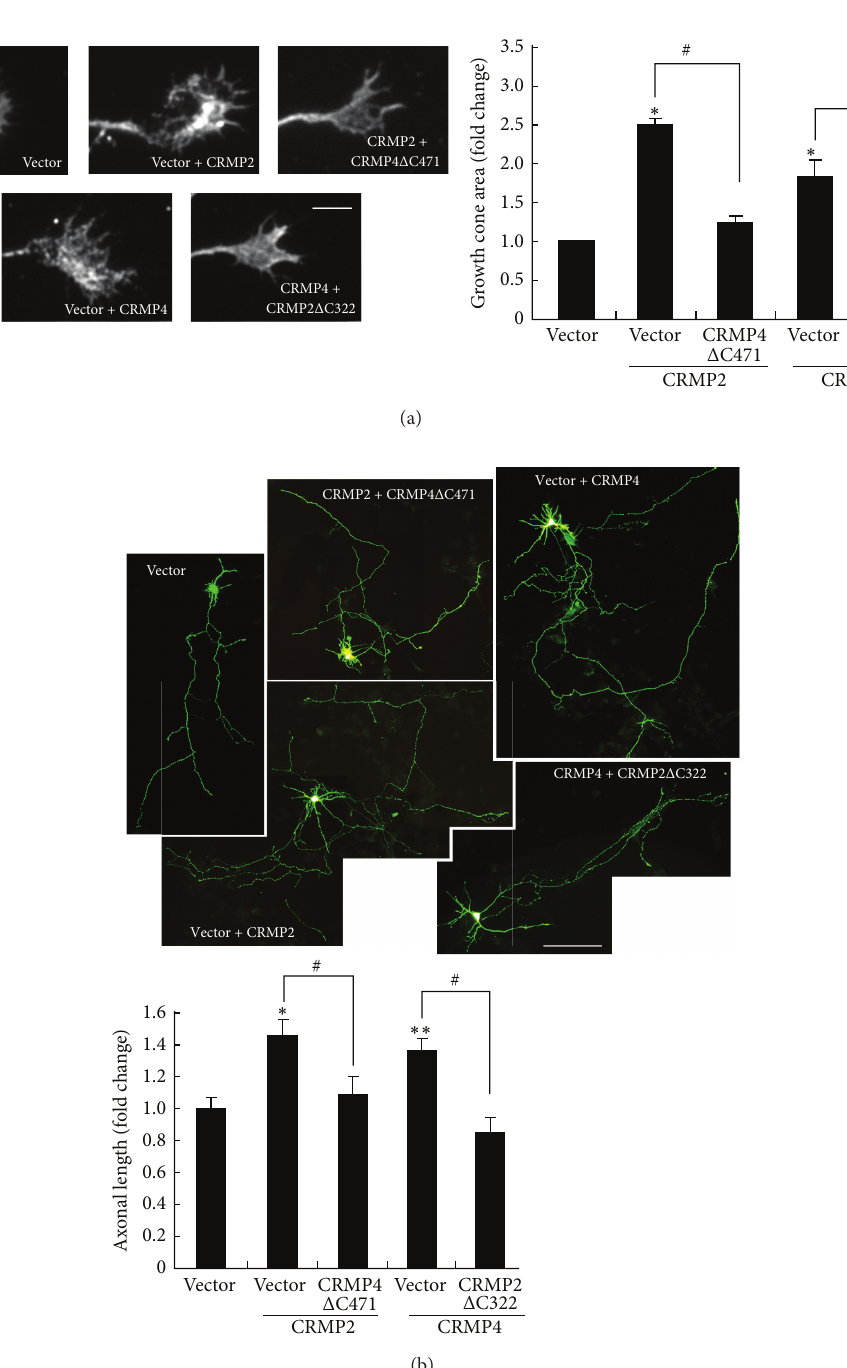
Figure 6: CRMP2 and CRMP4 interact with the cytoskeleton to promote growth cone development and axonal elongation. (a) Representative images of growth cones from neurons transfected with CRMP4 alone or together with CRMP2 Δ C322 or with CRMP2 alone or together with CRMP4 Δ C472 are shown. Scale bar: 10 𝜇 m. The relative ratio of the growth cone area was measured and is shown in the right panel. Mean ± SEM, 𝑛 = 4 ; ∗ 𝑃 < 0.05 versus vector control; # 𝑃 < 0.05 versus indicated group. (b) Representative images of GFP staining from hippocampal neurons with the same transfection as in (a) are shown. Axon length was measured as the mean ± SEM from three independent experiments. ∗ 𝑃 < 0.05 versus vector control; ∗∗ 𝑃 < 0.01 versus vector control; # 𝑃 < 0.05 versus indicated group. Scale bar: 100 𝜇